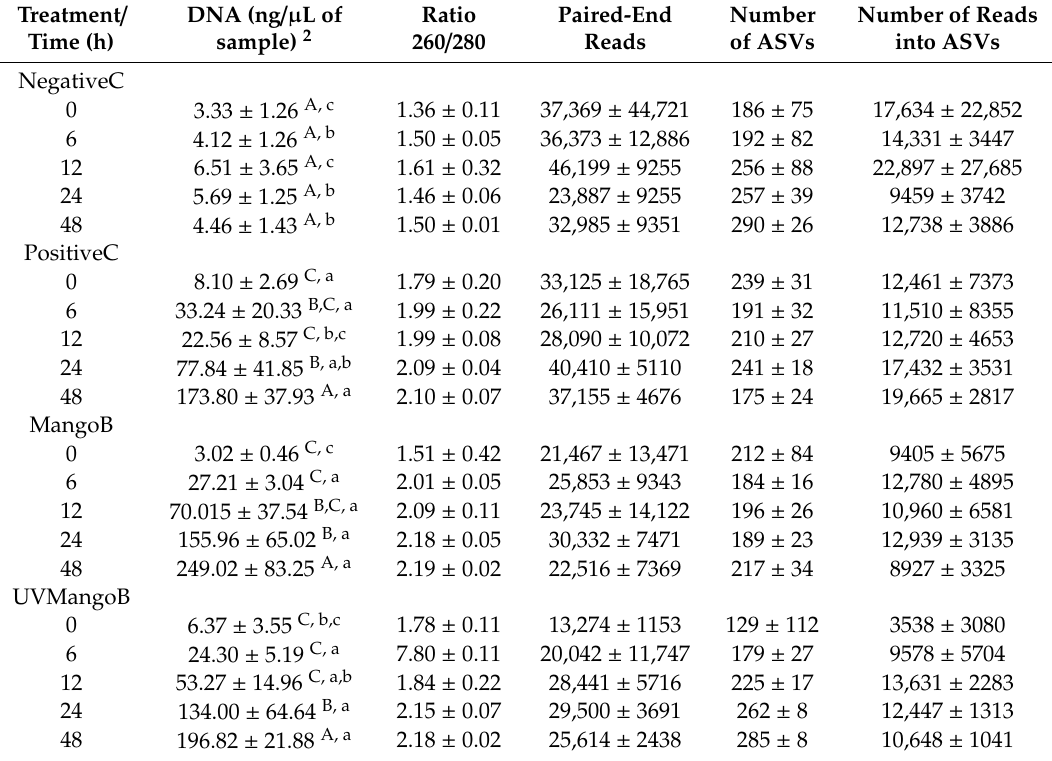
di ff erence (LSD) test, are indicated in column by di ff erent capital letters (A, B, C) within monitoring times for each treatment. Lowercase letters (a, b, c) indicated in same column significant di ff erences ( p < 0.05) between similar monitoring times of